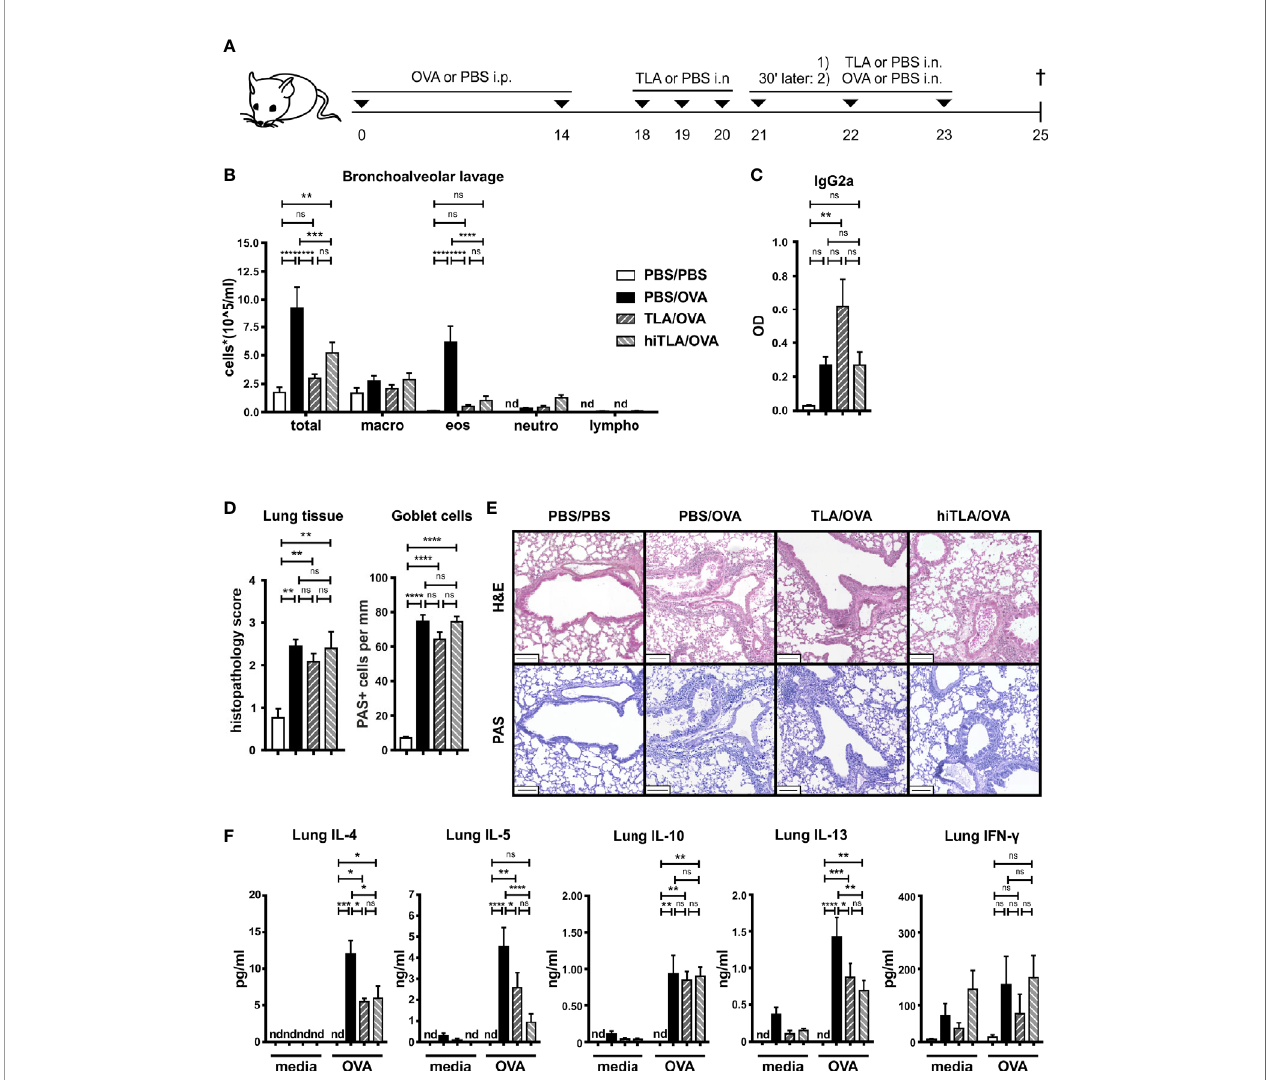
FIGURE 4 | Therapeutic treatment with native or heat-inactivated TLA reduces allergic airway in fl ammation. (A) Experimental design. (B) Differential cell count in bronchoalveolar lavage (BALF). (C) Levels of OVA-speci fi c antibody IgG2a in BALF collected at the end of the experiment. (D) Average histopathology score and number of Periodic acid-Schiff (PAS)-positive goblet cells of lung sections. (E) PAS or H&E-stained lung sections from 1 representative example from each group (n = 5); scale bars, 100µm. (F) Levels of IL-4, IL-5, IL-10, IL-13, and IFN- g after medium and OVA restimulation of lung cells. Graphs show results from 1 representative experiment from 2 independent experiments with 5 mice per group. Error bars show mean ± SEM. TLA , tachyzoites lysate antigen; hiTLA , heat- inactivated; OVA, ovalbumin; i.n., intranasal; i.p., intraperitoneal; macro, macrophages; eos, eosinophils; neutro, neutrophils; lympho, lymphocytes; n.s., not signi fi cant; OD, optical density; *P < 0.05; ** P < 0.01; *** P < 0.001; ****P <